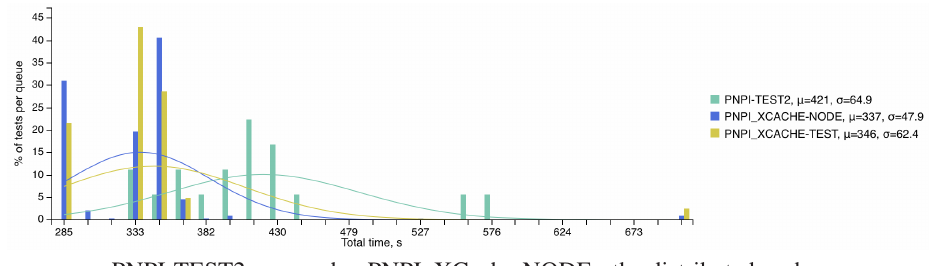
Figure 5. Total time distribution of copy2scratch tests per